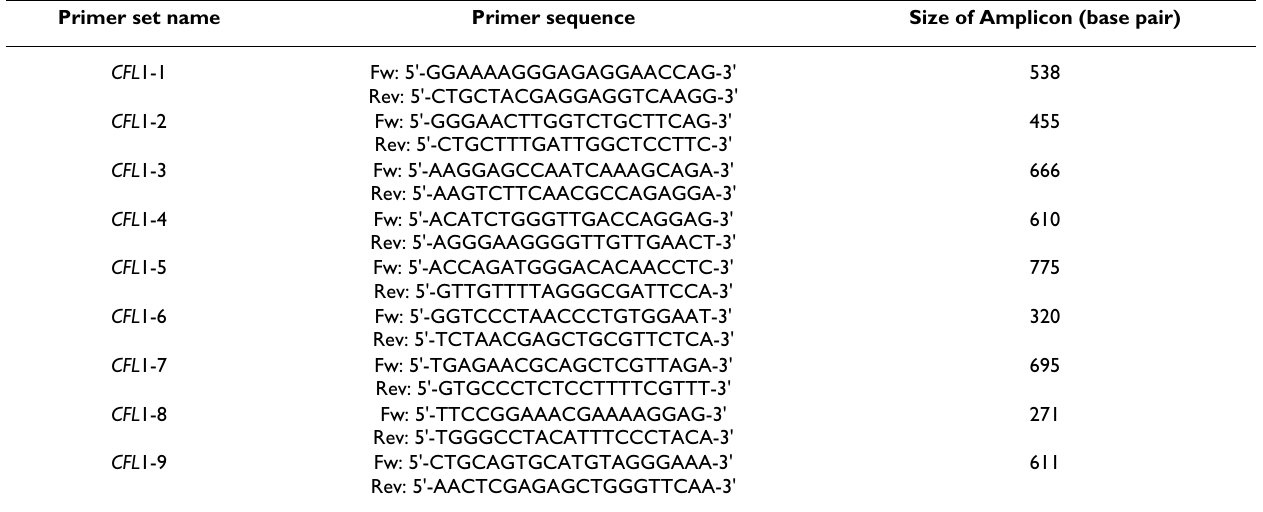
Table 1: Primer sequences for re-sequencing of CFL1 gene Primer set